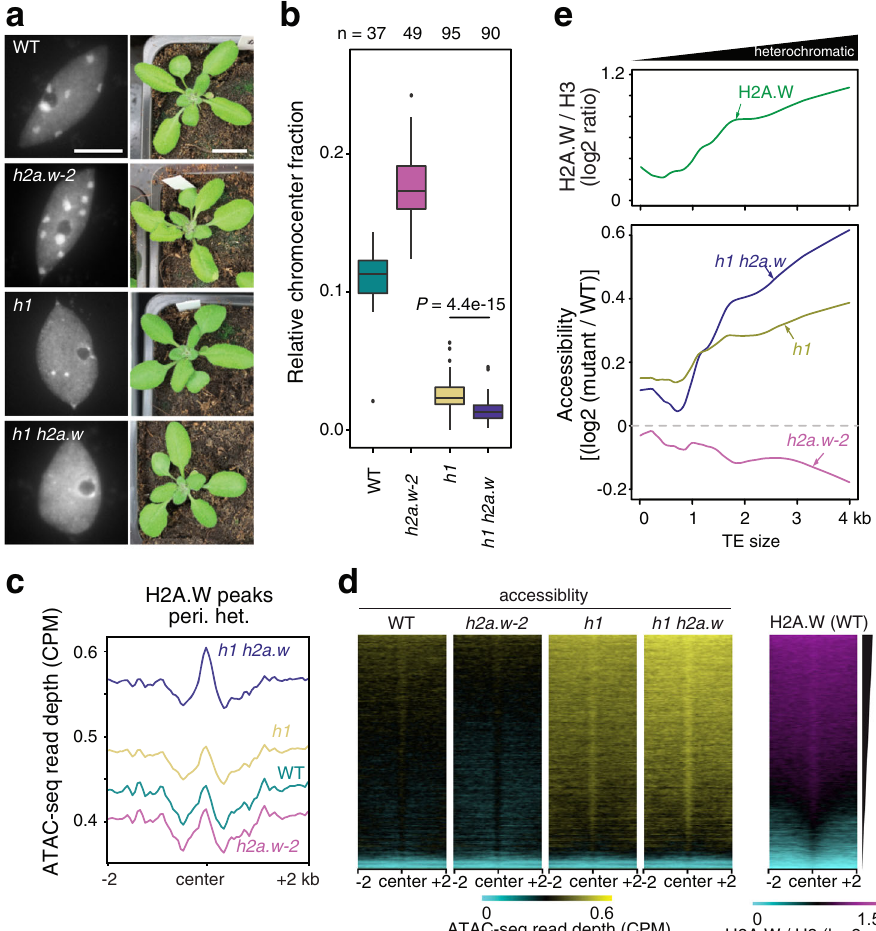
Fig. 6 H2A.W and H1 co-regulate heterochromatin accessibility. a Representative images of DAPI-stained WT (Col-0), h2a.w-2, h1 and h1 h2a.w leaf interphase nuclei (left; scale bar is 5 µ m) and of 3-week-old plants of the same genotypes (right; scale bar is 1 cm). Nuclear preparation and analysis were independently repeated three times with similar results. b Quanti fi cation of the relative chromocenter fraction in WT (Col-0), h2a.w-2, h1 and h1 h2a.w nuclei. Number of analyzed nuclei are indicated on the top. Whiskers indicate 1.5X IQR. Outliers are represented by circles. Relative chromocenter fraction in h1 and h1h2a.w show statistically signi fi cant difference ( P = 4.4e-15, unpaired Mann – Whitney test). c ATAC-seq read depth over H2A.W peaks in pericentromeric heterochromatin. Average of two replicates shown. d Heat maps of average ATAC-seq read depth over H2A.W peaks in pericentromeres ranked based on level H2A.W signal in WT. e Locally weighted scatterplot smoothing (LOESS) fi t of WT H2A.W levels (log 2 ChIP/H3; top panel)